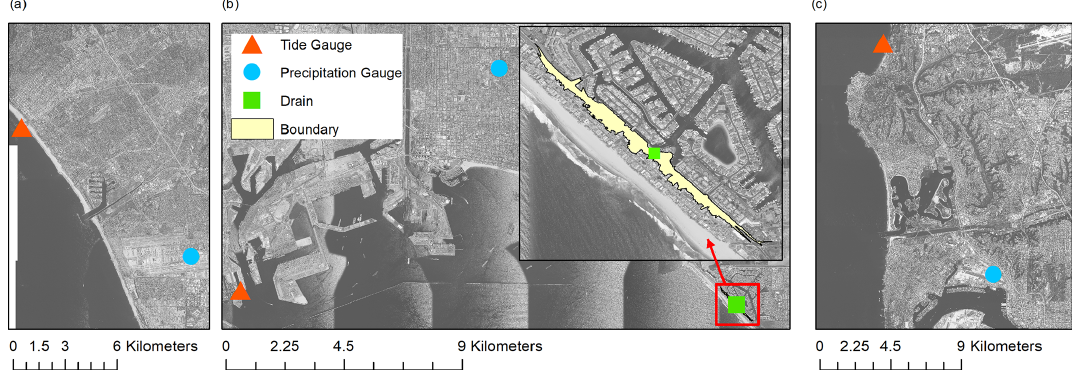
Figure 1. Map displaying (a) Santa Monica, (b) Sunset, and (c) San Diego sites along with locations of tide gauges (triangle) and precipitation stations (circle). The road drain (square) and boundary (yellow) at Sunset ( ∼ 2km 2 ) are for the structural scenario. Aerial imagery from NOAA (2021a).